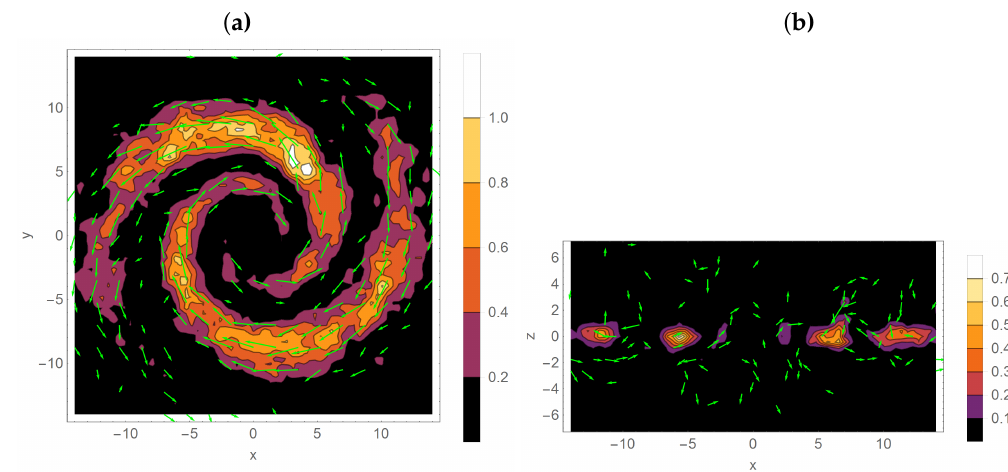
Figure 3. Distribution of model magnetic field: ( a ) in central horizontal galactic plane, ( b ) in central vertical plane. Colour scale shows magnetic field intensity in µ G. Arrows denote magnetic field direction.